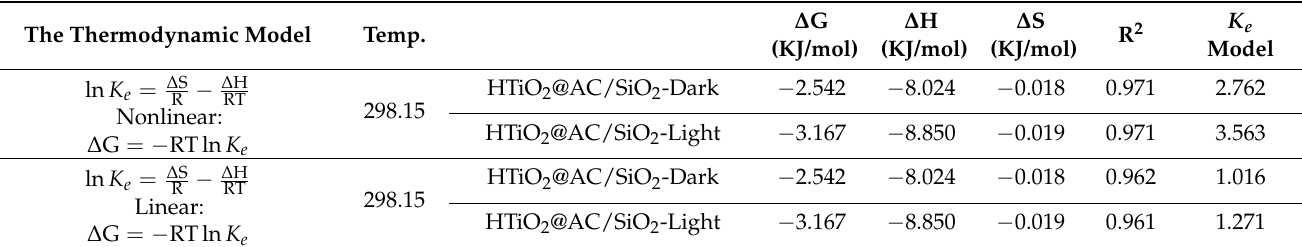
Table 4. The Thermodynamic